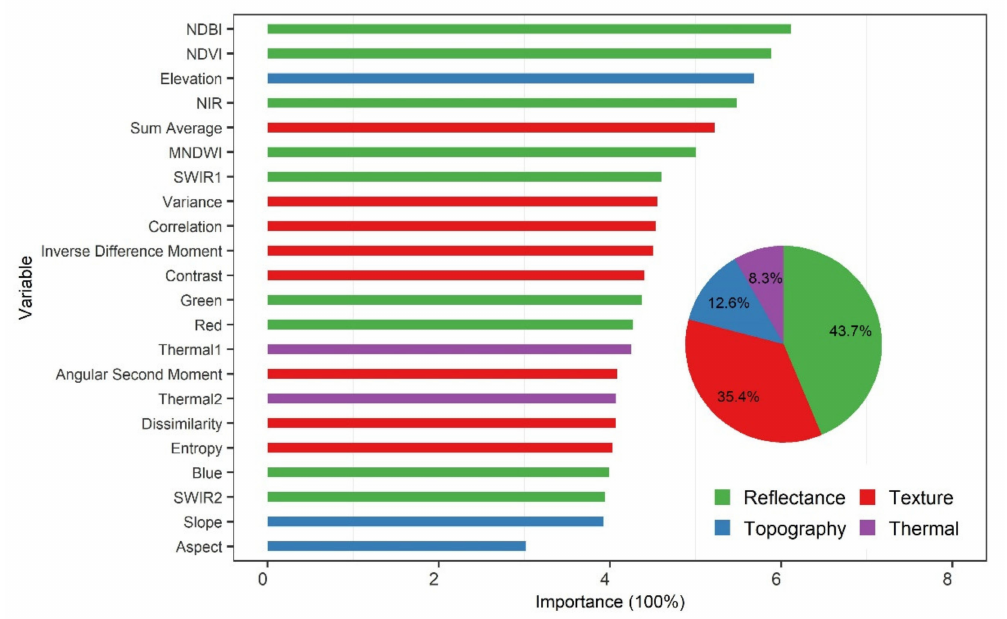
Figure 5. Variable importance in the Random Forest model trained with variables from reflectance spectra, texture, topography, and thermal spectra; the pie indicated the importance of each